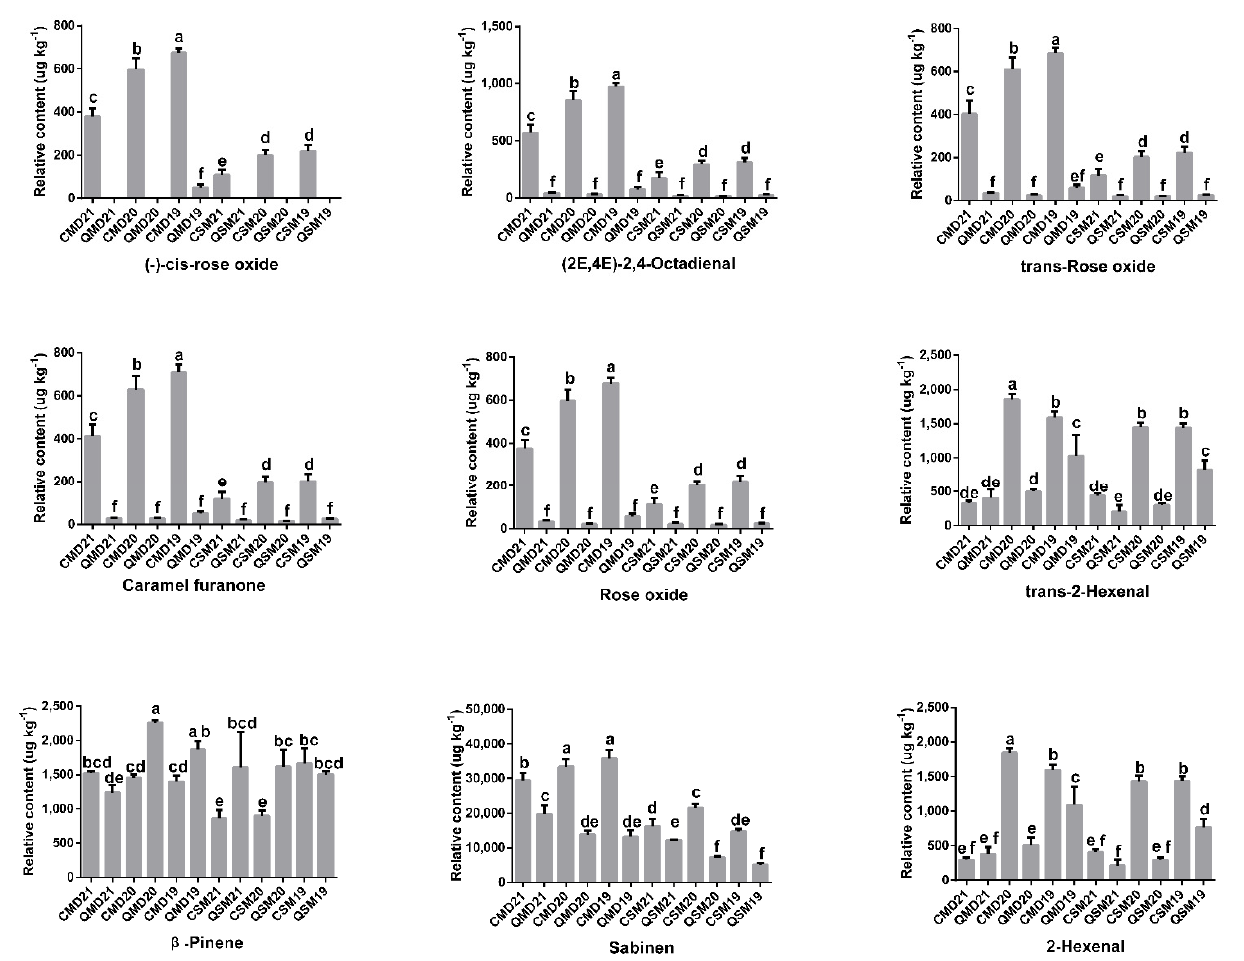
Figure 7. The relative content of nine aromatic compounds which had OAV > 1. The different superscripts show significant differences ( p < 0.05). White teas picked in spring were called SPWTs and those picked in autumn were called APWTs. White peony teas and Shou Mei picked in spring were termed CMD19-21 and CSM19-21, respectively, while those picked in autumn were correspondingly named QMD19-21 and QSM19-21. The number following CMD, QMD, CSM, and QSM represented the production years, corresponding to 2019, 2020, and 2021, respectively (Table 1).